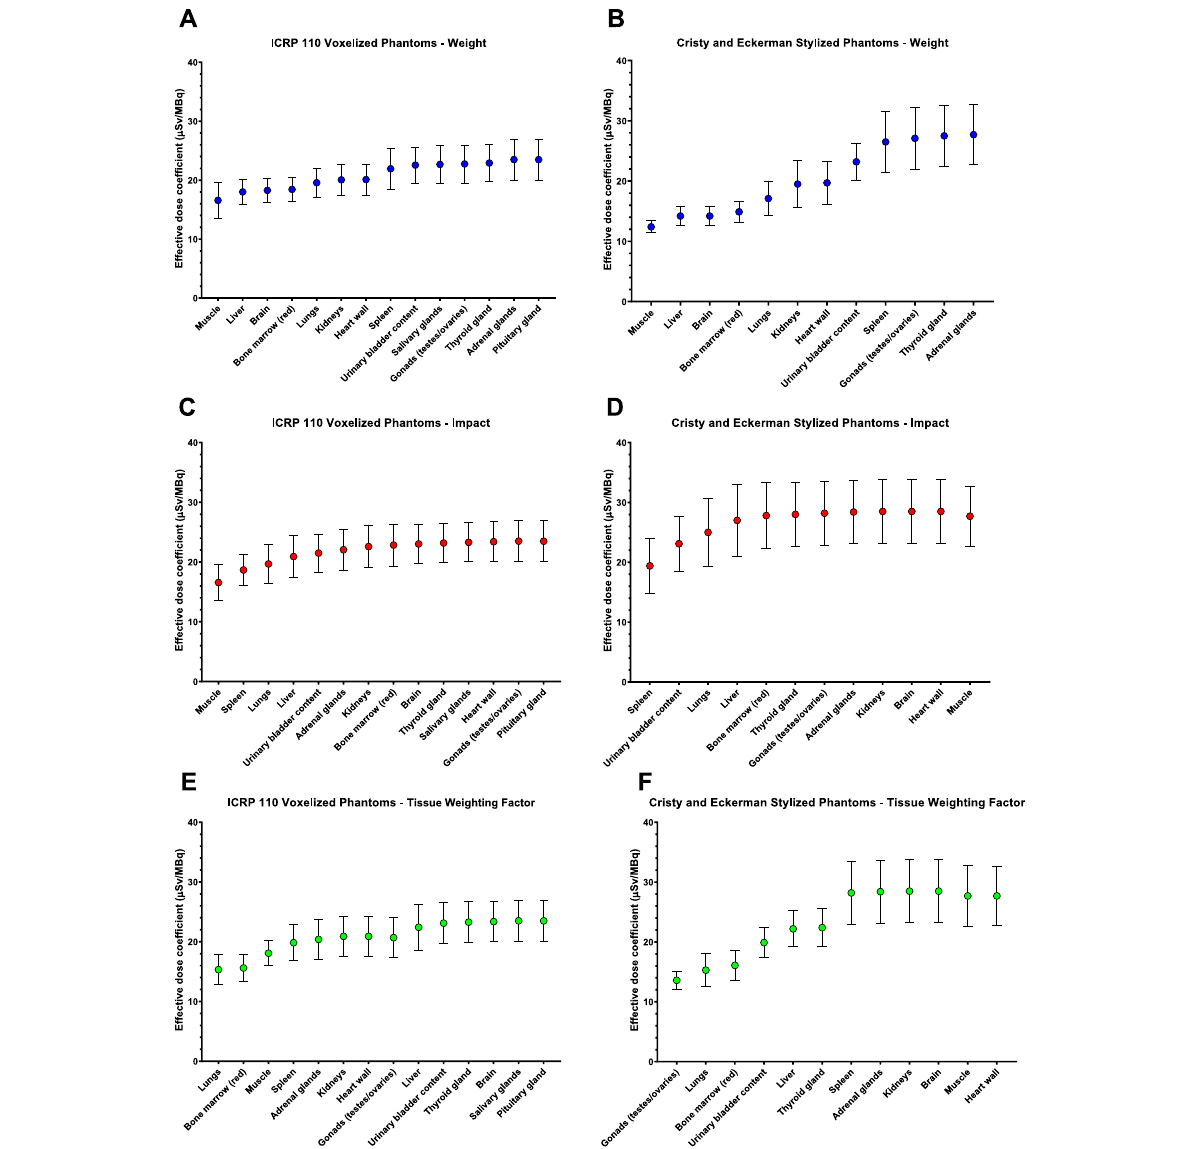
Fig. 1 The effective dose coefficient, e , in units of μ Sv/MBq as a function of the number of tissues/organs included in the dosimetric calculations regarding a , b weight (decreasing); c , d impact (decreasing); and e , f tissue weighting factors, w T , (decreasing) for the ICRP Publication 110 voxelized reference phantoms and CE stylized reference phantoms, respectively. The error bars show the standard deviation